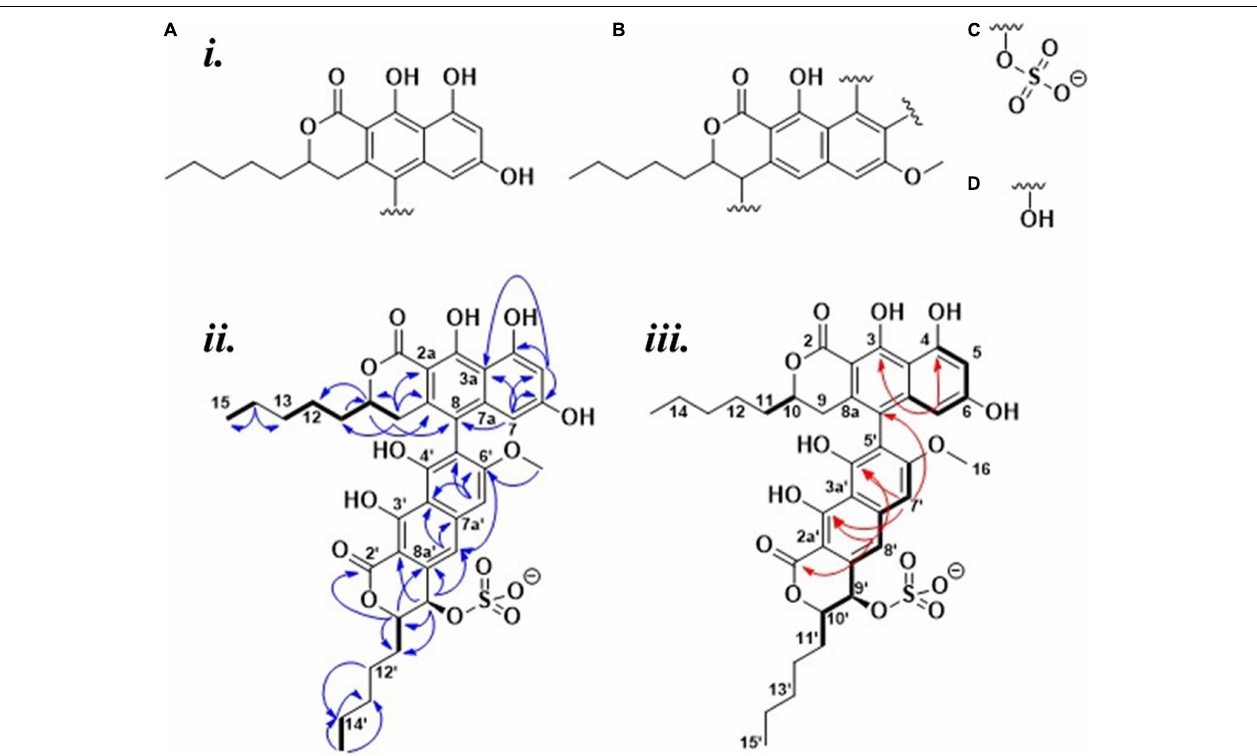
FIGURE 3 | ( i ) Fragments identified for 2 : (A,B) The napthopyrone-like moieties; (C) a sulfate group; (D) a spare hydroxyl group. ( ii ) Elucidated structure of 2 : Bold bonds = COSY, blue arrows = HMBC, and ( iii ) red arrows = weak 4 J CH correlations, Bold bonds =